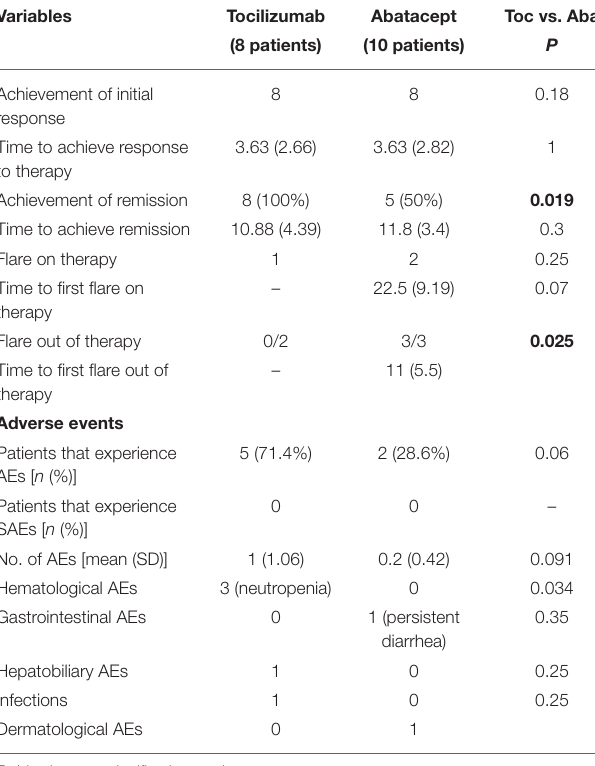
TABLE 3 | Main outcomes and adverse events.